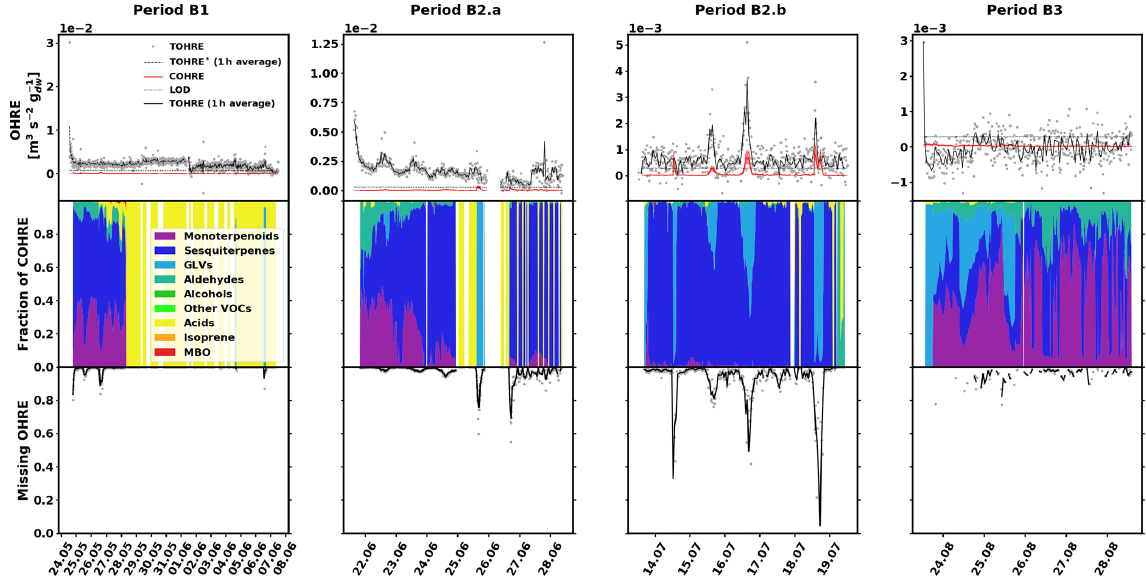
Figure 4. Measured total OH reactivity of the emissions (TOHRE), its 1h average values, and COHRE normalised to dry weight (top row) for birch. (The dashed line, TOHRE ∗ , designates the time when the dry weight of the leaves is significantly smaller than measured at the end of the period B1, leading to unreliable values of TOHRE.) Fraction of the various contributions of chemical species to COHRE (middle row). Missing fraction of OHRE (bottom row). The periods are denoted “B” for “birch”, the number indicates which branch is being measured, and the letter indicates which period it is for the same